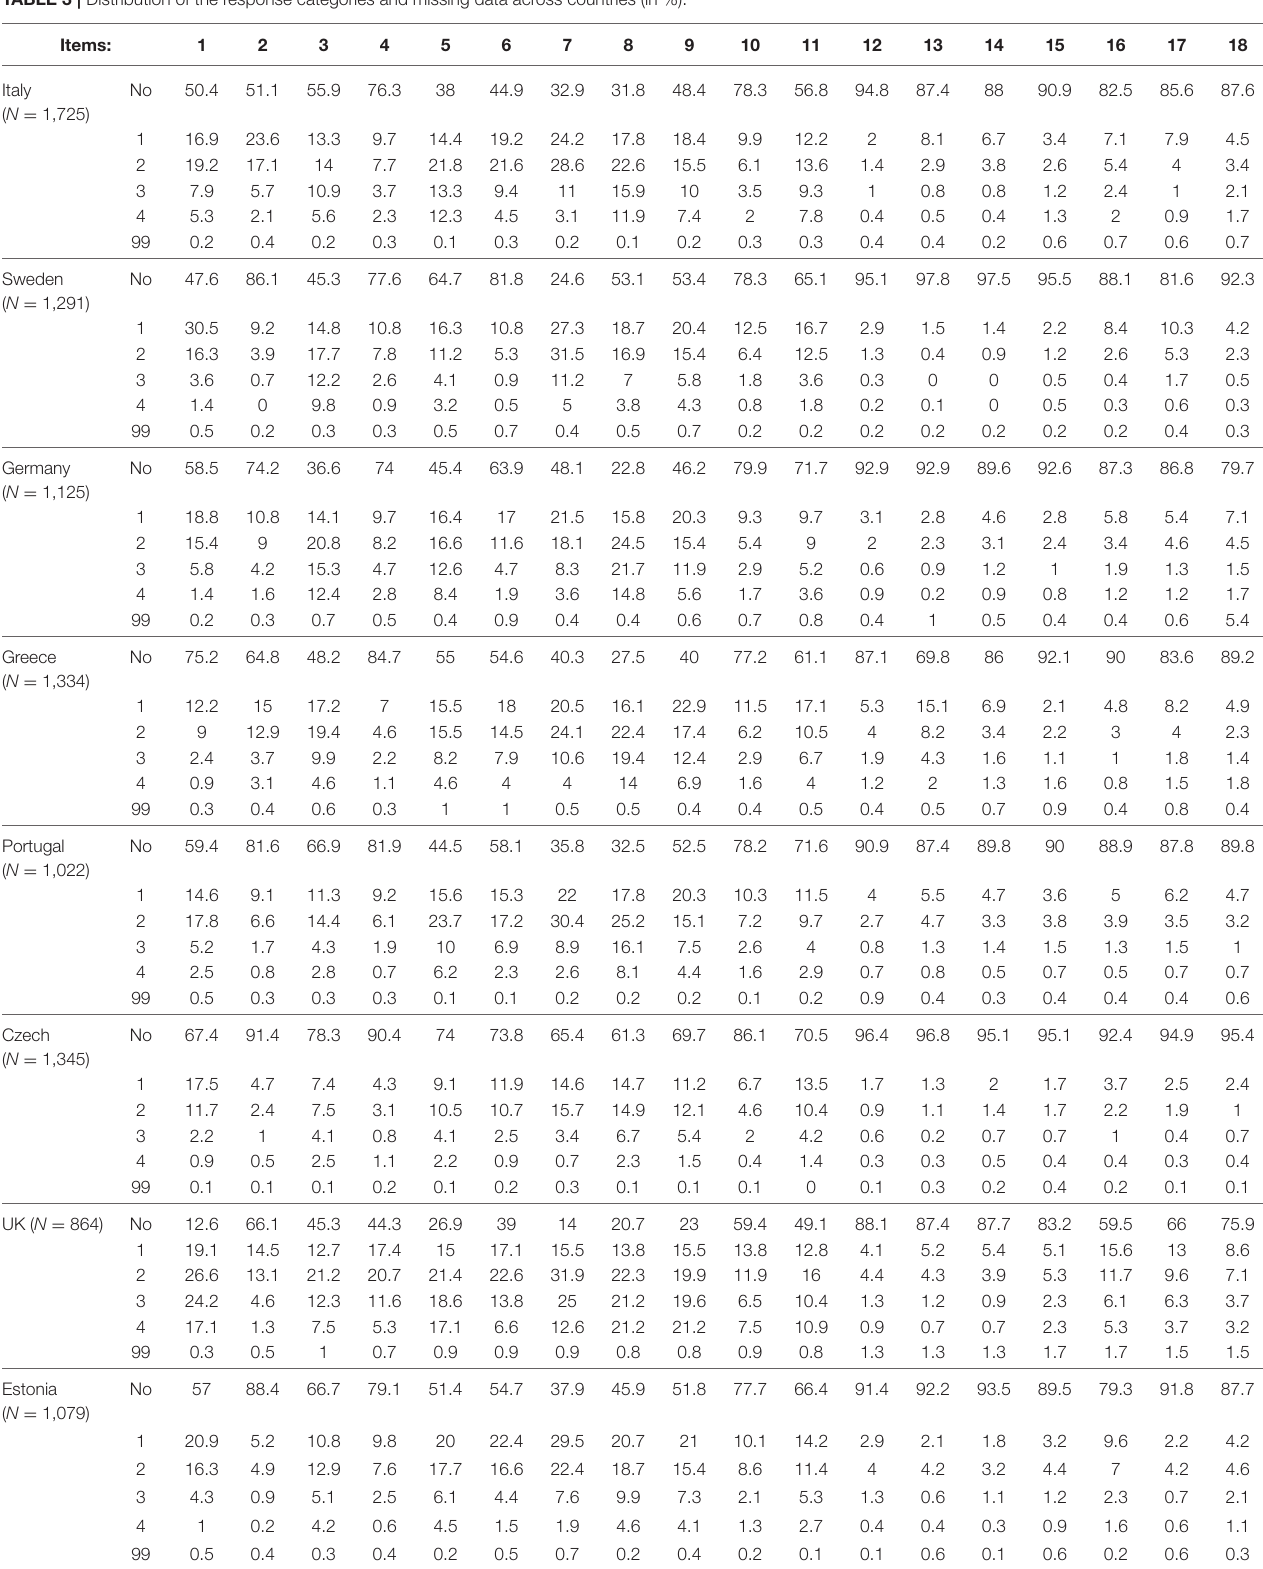
TABLE 3 | Distribution of the response categories and missing data across countries (in %).